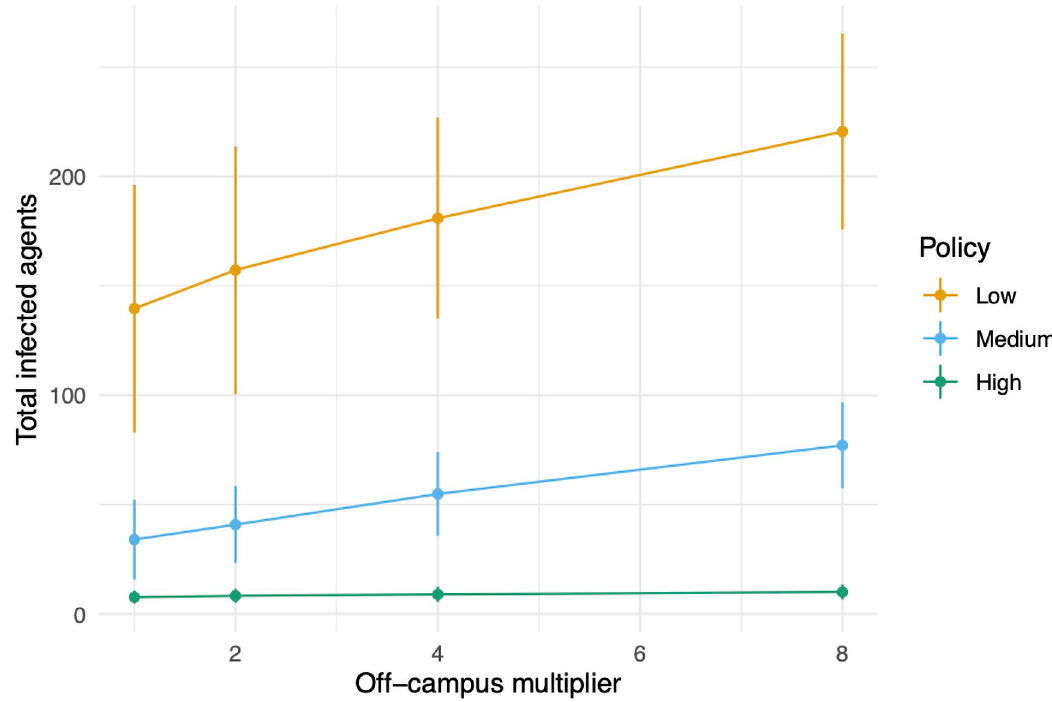
Fig 11. A sensitivity analysis of the off-campus multiplier. We fix the student adherence to be medium, and show the total number of cases for each of the three administrative policies.